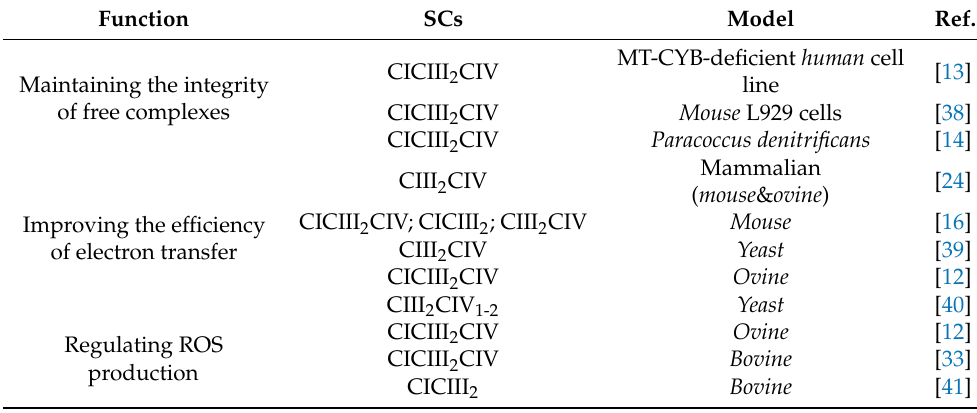
Table 2. Functions of SCs in various